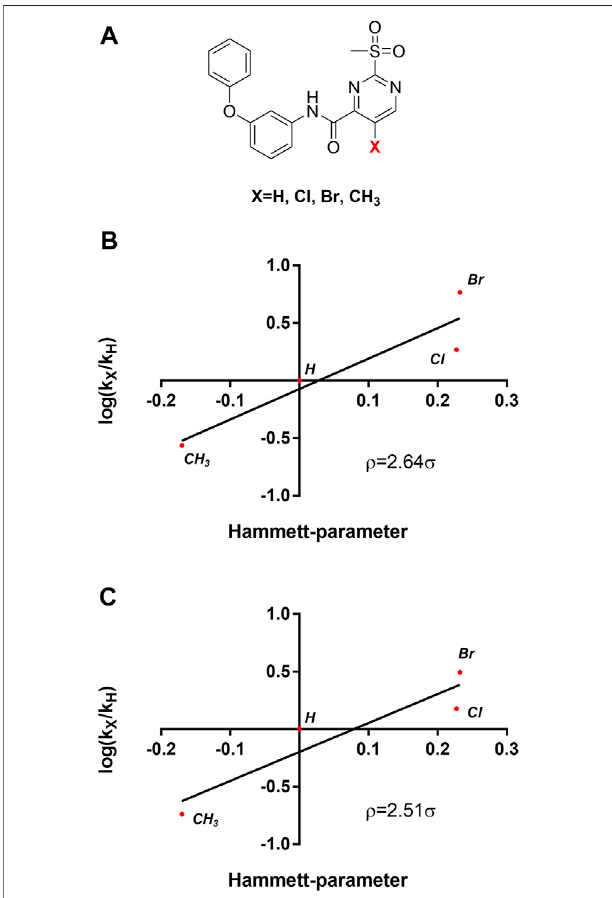
FIGURE 8 | Mechanistic analysis by Hammett plots. (A) Substituent series based on compound 5a used for kinetic characterization. (B) Hammett plotfortheinactivationofSrtAbysulfonylpyrimidines. (C) Hammettplotforthe reactionofsulfonylpyrimidineswithcysteineinsolution(phosphatebuffer pH